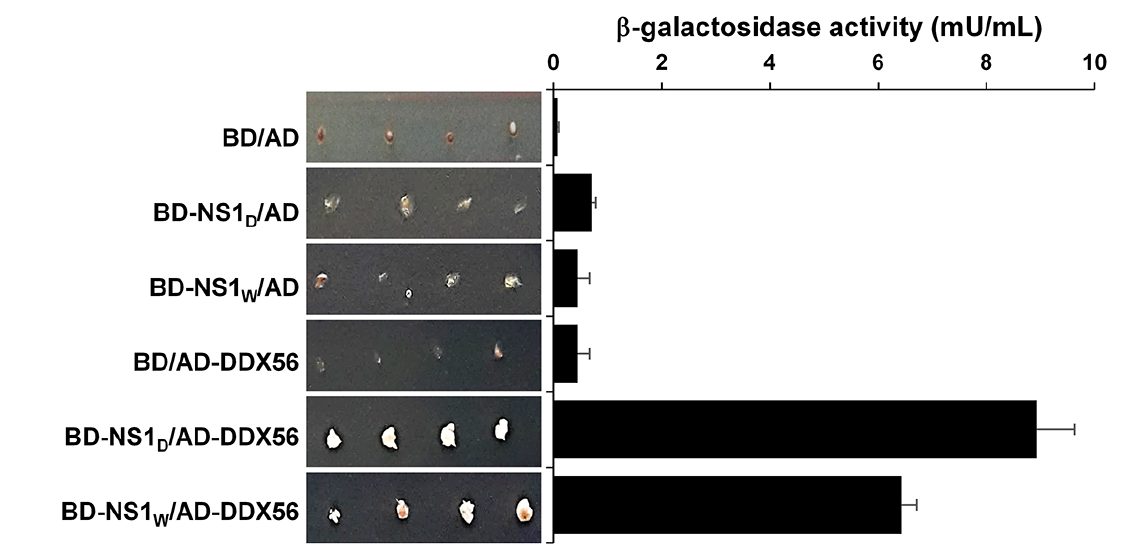
Figure 1 – The growth profiles and β-galactosidase activity of double transformed S. cerevisiae strain PJ69-4A with yeast two-hybrid plasmids. The yeast cells were transformed with a plasmid coding GAL4-binding domain (BD) (pGBD-C1) or viral NS1 bait protein fused with GAL4-BD (pGBD-NS1 or pGBD-NS1 ) and then with a plasmid coding GAL4-activation domain (AD) (pACT2) or human DDX56 protein fused with GAL4-AD (pACT2- D DDX56). To define the growth profiles, four colonies were cultured on SD agar plates (without Ade, His, Leu, and Trp). The β-galactosidase enzyme activities of the colonies were defined as described in